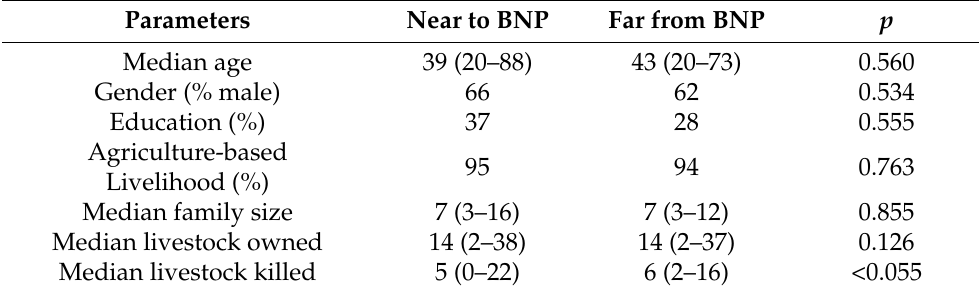
Table 1. Attributes of respondents and their livestock living near (<1 km; n = 147) and far (>1 km; n = 153) from Bardia National Park (BNP), Nepal, 2015–2019. Parameters included age (years), gender (male or female), education (educated: people who attended school through grade five or above; non-educated: people who did not go to school or attended school through grade four or less), occupation (agricultural: if daily life is sustained from agricultural products; or other: if their daily livelihood depends on non-agricultural income), family size (number of individuals), total livestock owned (all hoofed livestock including cattle, buffalo, and goats), and total livestock killed (number of livestock killed including cattle, buffalo, and goats). Range of reported values are in parentheses.